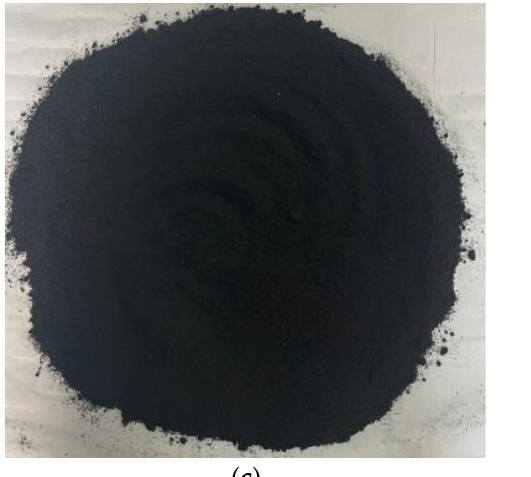
Table 1. Material Requirement for 1 m 3 mix of IPB of CR and CCF Batches.